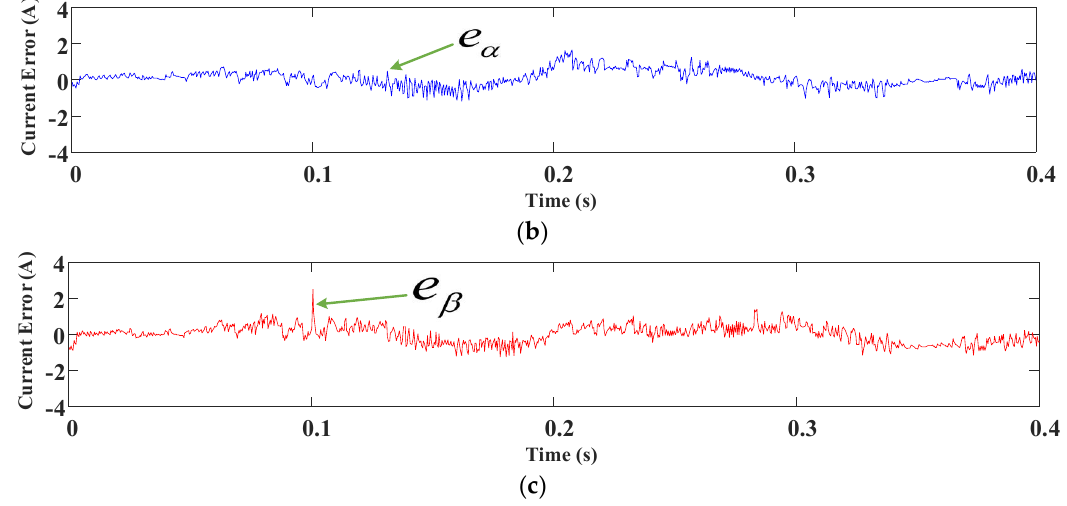
Figure 17. Experimental results of DVV-MPCC following a sinusoidal current command with amplitude jumping from 2 A to 5 A at 0.1 s under frequency 10 Hz (case 3): ( a ) current responses; ( b ) α -axis current error; ( c ) β -axis current error.